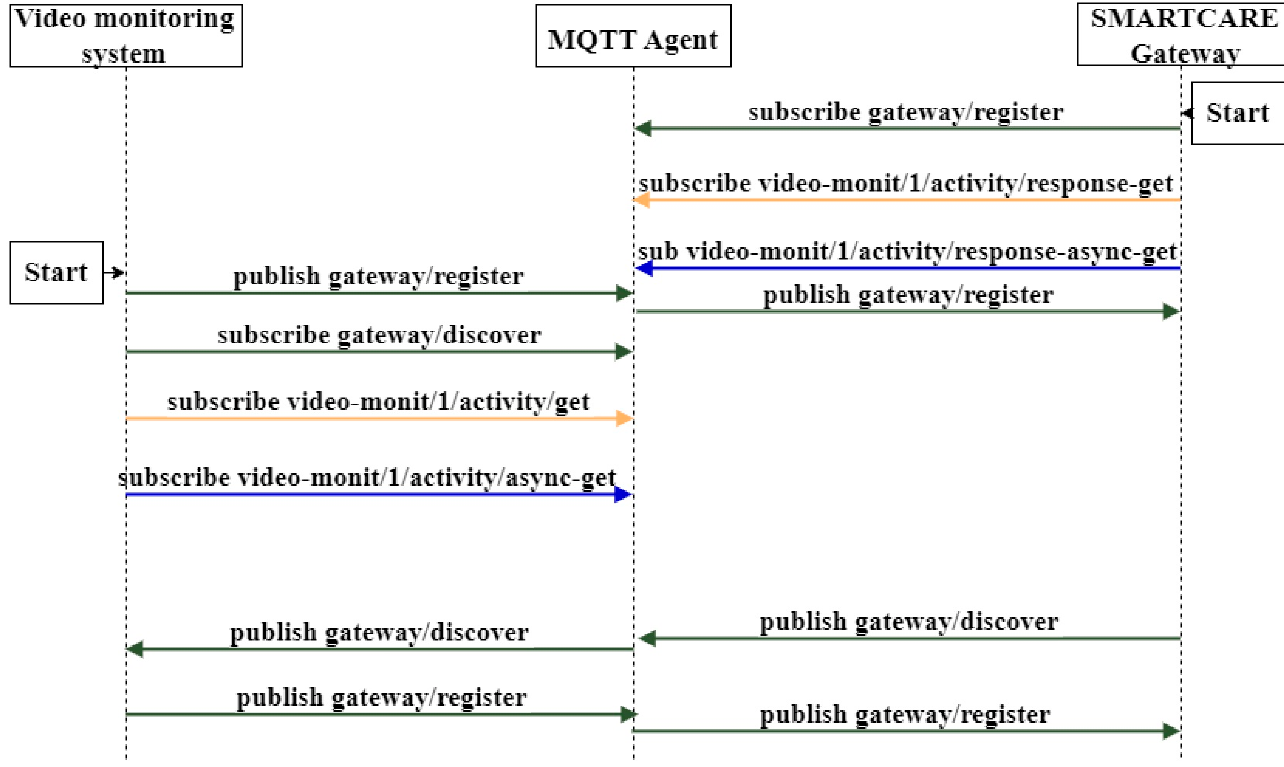
Figure 12. Initialization sequence for the connection between the HAR module and the SmartCare Gateway.